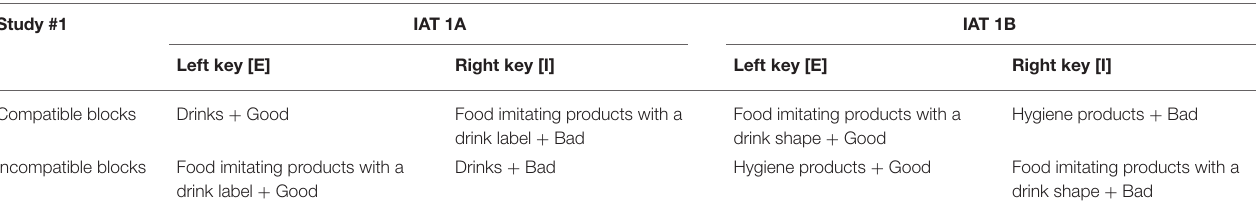
TABLE 3 | Response mappings in IATs 1A and